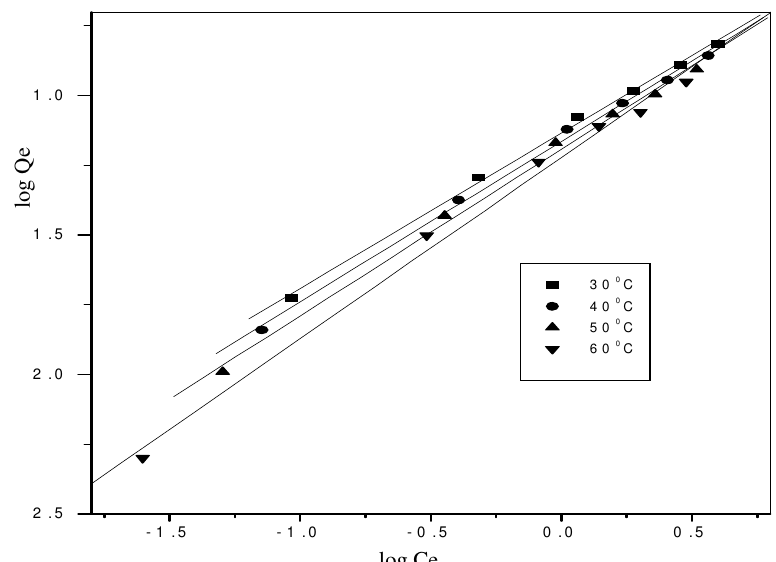
Figure 4. Freundich adsorption isotherms for the adsorption of chromium